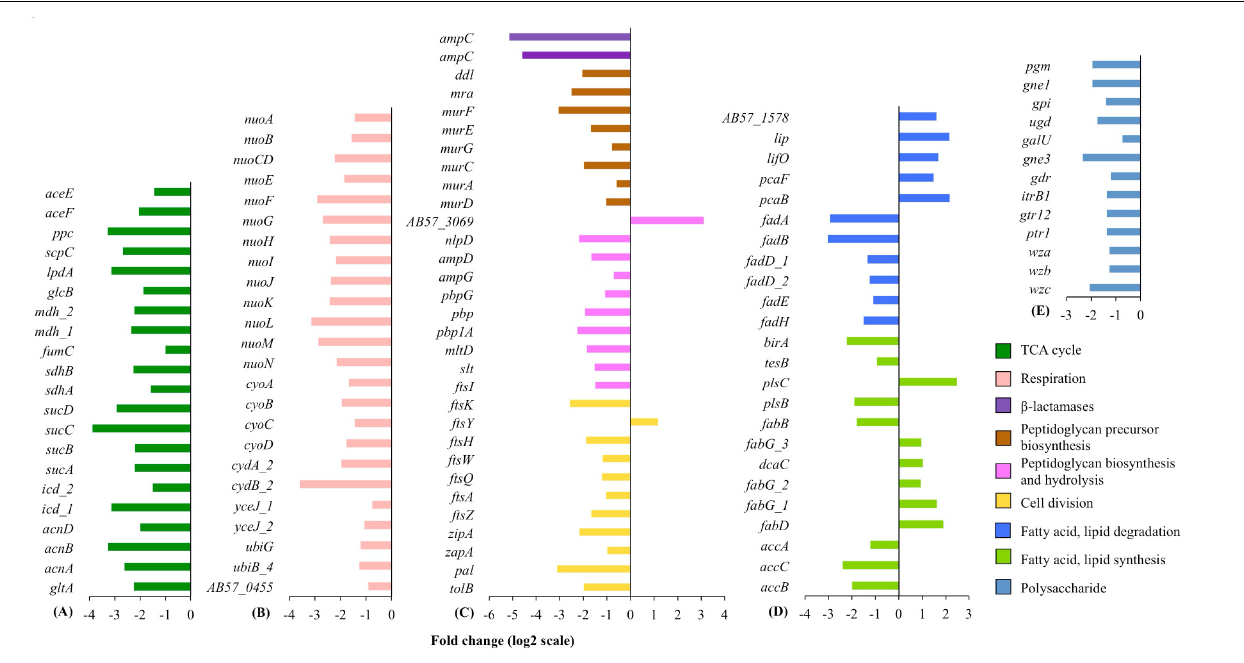
FIGURE 2 | (A) TCA cycle, (B) respiration, (C) cell wall and cell division, (D) fatty acid and lipid, and (E) polysaccharide. Differential transcription of genes in key metabolic pathways. For each cellular pathway, only differentially transcribed genes with absolute fold changes > 1 (log 2 scale) and padj < 0.01 are shown. The bar charts are grouped by colors according to the biological functions of the genes assigned, with the color scheme on under panel (E) . Full information on gene function annotations is given in Supplementary Data